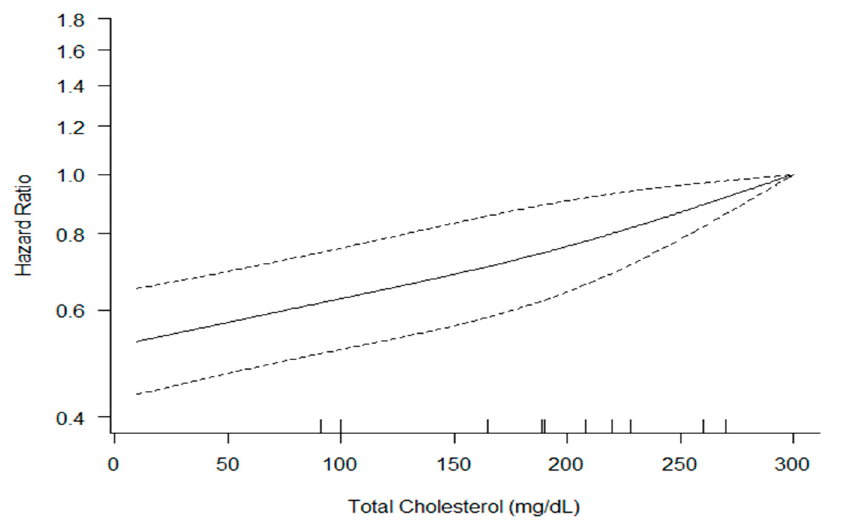
Figure 4. Dose-response meta-analysis between serum total cholesterol level and the hazard ratio of CVD mortality. The solid line represents point estimates of the association of serum total cholesterol and CVD mortality with the use of restricted cubic splines models, and the dashed lines indicate 95%